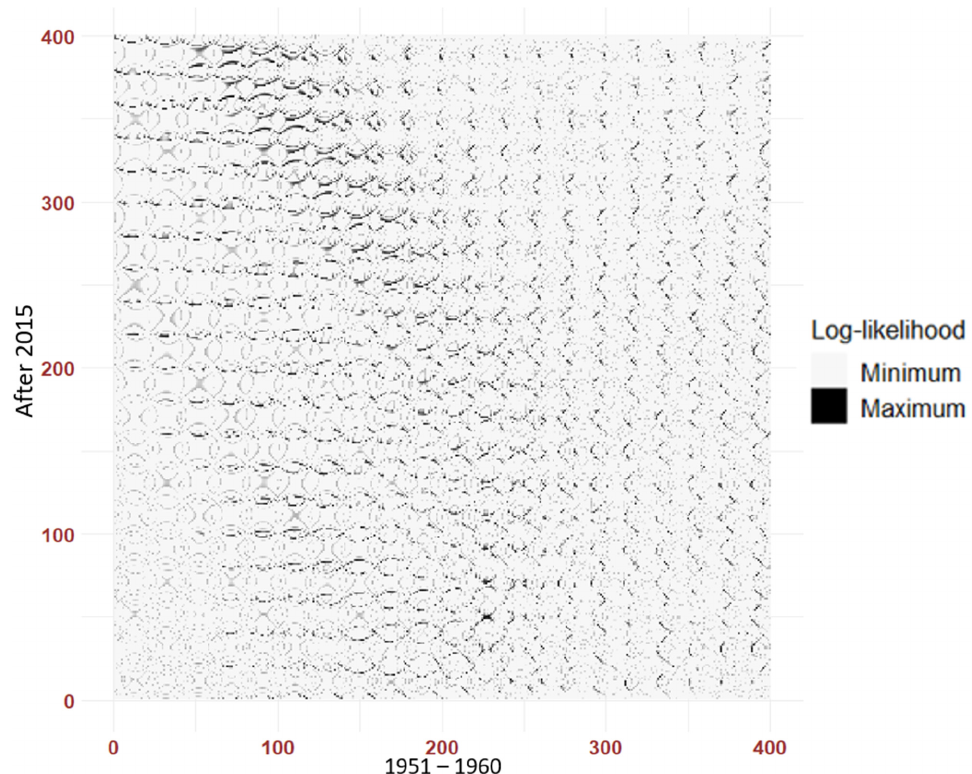
Figure 7. Distribution of top 10% log-likelihood for the combination of the initial values.